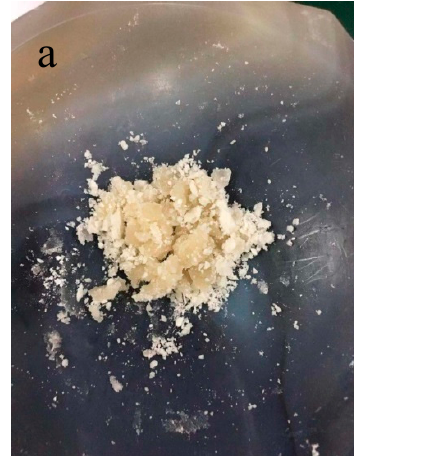
Figure 10. 29 Si MAS NMR spectra of S–Si–SOD zeolites crystallized at 200 °C for ( a ) 0, ( b ) 8, ( c ) 12, ( d ) 14, ( e ) 16, and ( f ) 24, respectively. Crystals 2018 , 8 , x FOR PEER REVIEW